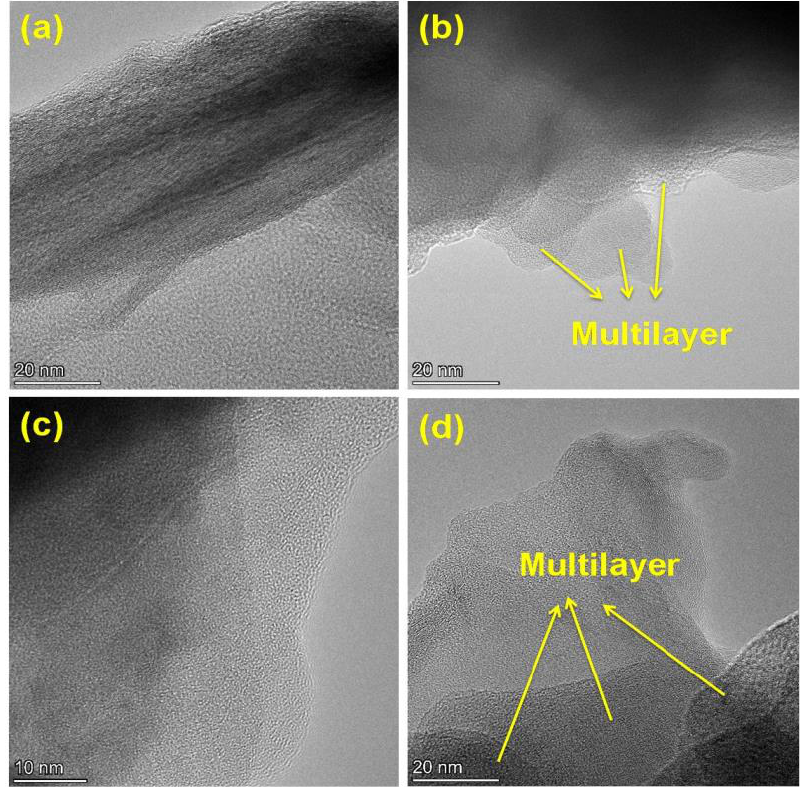
Figure 4: TEM images of GO ( a , b ) and rGO ( c , d ). The TEM images of GO and rGO show a layered structure and flat multilayer morphology.